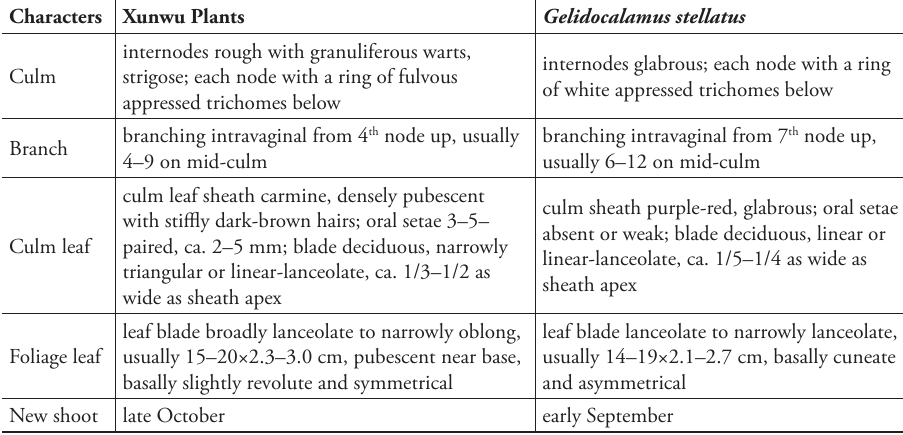
Table 1. Comparison of morphological traits of the Xunwu population plants with those of Gelidocala- mus